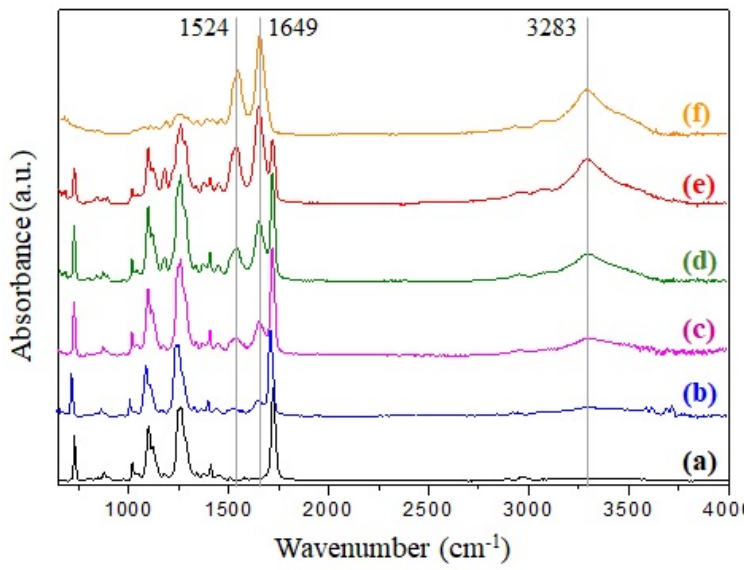
Figure 2. FTIR spectra of (a) r-PET, (b) r-PSF4, (c) r-PSF5, (d) r-PSF6, (e) r-PSF7, (f) SF. The common characteristics bands of poly(ethylene terephthalate) are observed in Figure 2a. The band at 724 cm − 1 is attributed to the interaction of polar ester groups and benzene rings, at 1265 cm − 1 to the terephthalate group (OOCC 6 H 4 –COO), at 1050 cm − 1 to ester C–O bond, and band at 1714 cm − 1 is corresponding to C=O stretching [85,86]. Enhancing of the bands in the case of r-PSF4, r-PSF5, r-PSF6, r-PSF7 (Figure 2b–e) belonging for the amide groups of silk at 1240 cm − 1 (amide III, C–N stretching), 1649 cm − 1 (amide I, C=O stretching), 1524 cm − 1 , and 3283 cm − 1 (amide II, N–H bending) correspond to the increasing of SF concentration, which was attributed to the random coil, α -helix,